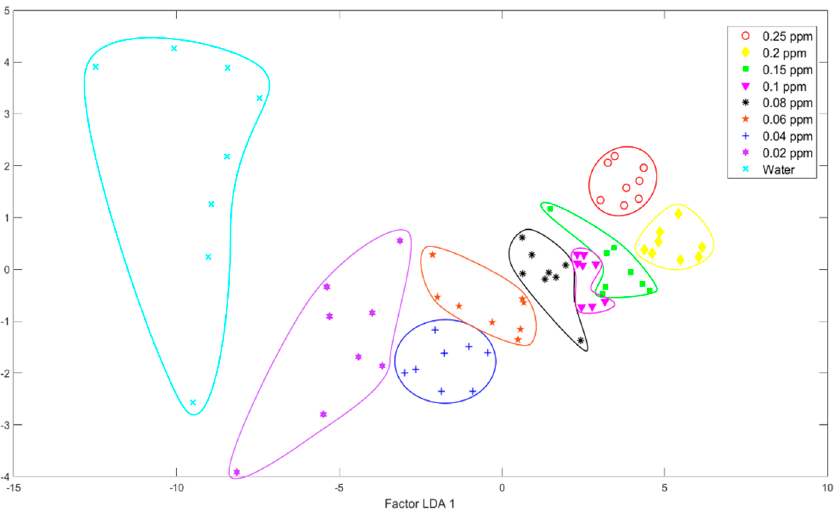
Figure 9. LDA plot using the carbon electrode (C110) for Curathane pesticide classification at different concentrations against distilled water.